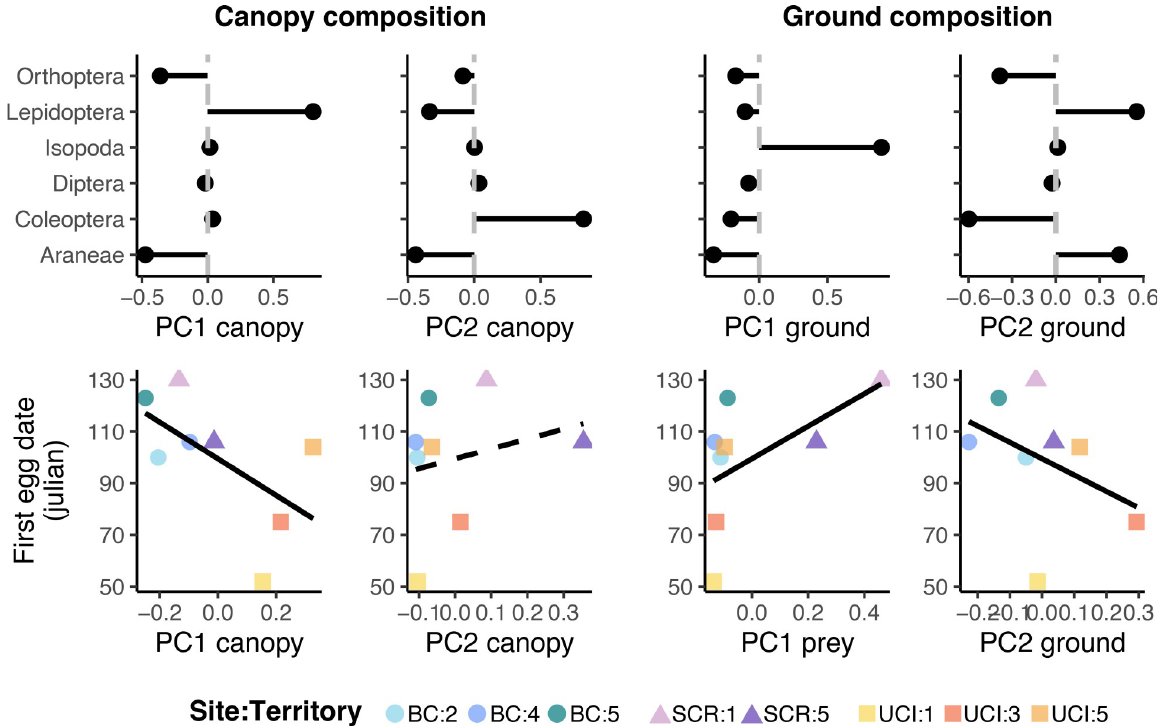
Fig 6. Territory-level relationships between arthropod prey composition and first egg date in plant canopies and on the ground. PC loadings are provided in the first row for PC axes representing variation in arthropod prey composition. Variation in composition is considered separately for canopy (columns 1 & 2) and ground (columns 3 & 4) arthropods. Trend lines indicate significant (P < = 0.05) correlation between axes. PC1 and PC2 for canopy composition explain 50% and 29% of variation and for ground composition explain 58% and 29% of variation (see S4 Fig in S1